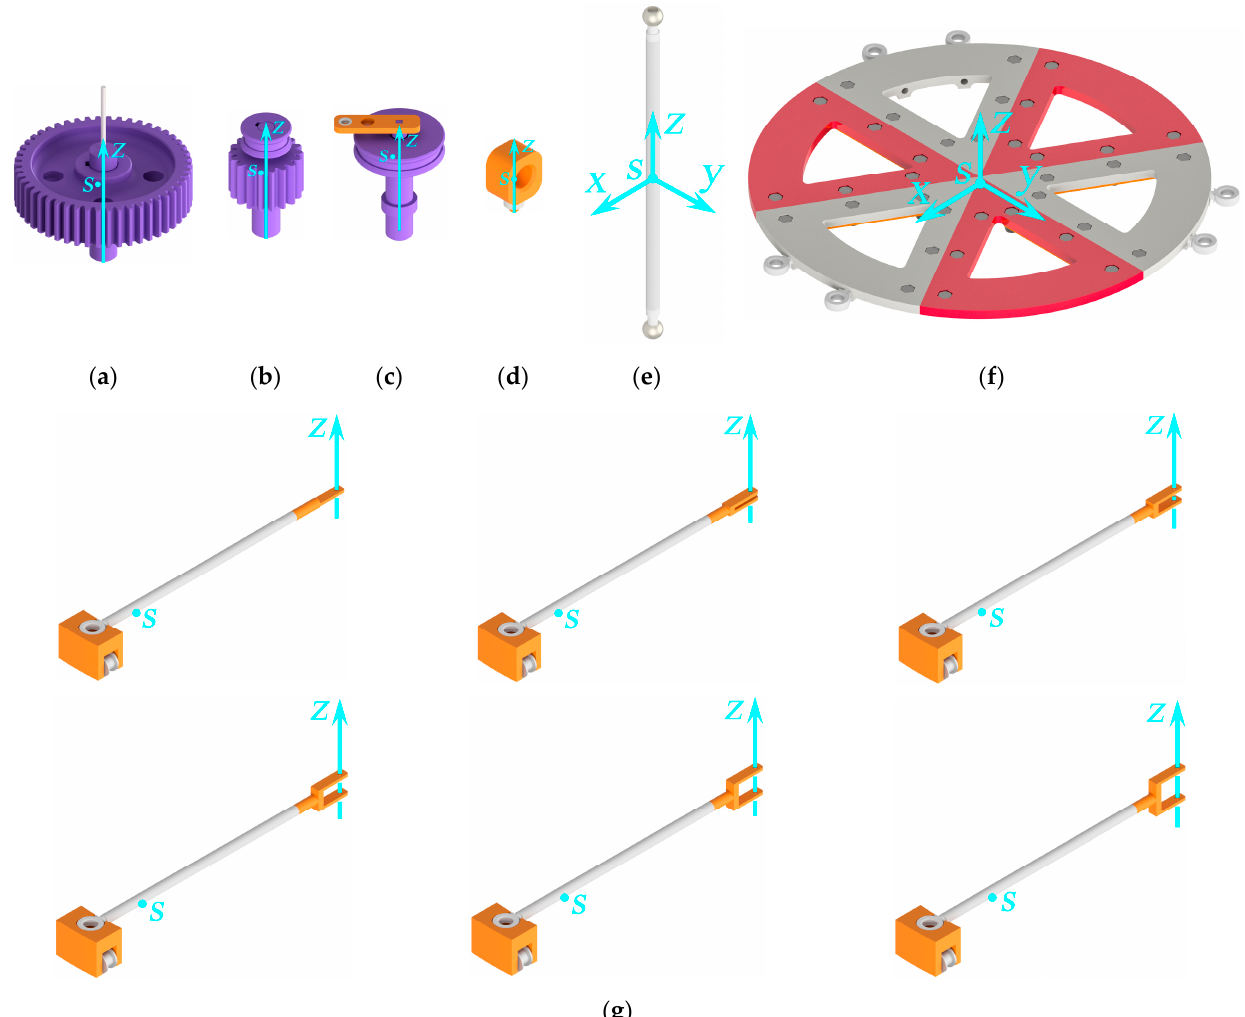
Figure B1. Definition of the inertia terms based on the hexapod elements geometry. Figure A1. Definition of the inertia terms based on the hexapod elements